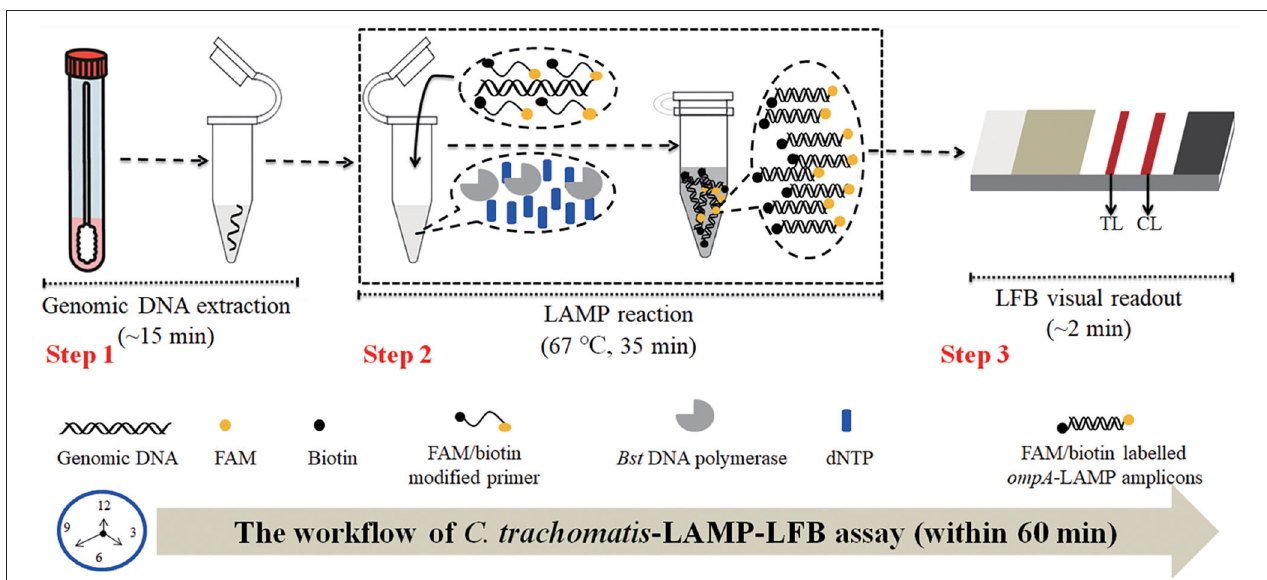
FIGURE 1 | C. trachomatis -LAMP-LFB workflow. C. trachomatis -LAMP-LFB assay contains three steps: genomic DNA preparation (step 1), LAMP reaction (step 2), and LFB visually readout (step 3). The whole diagnosis procedure can be completed within 60min.